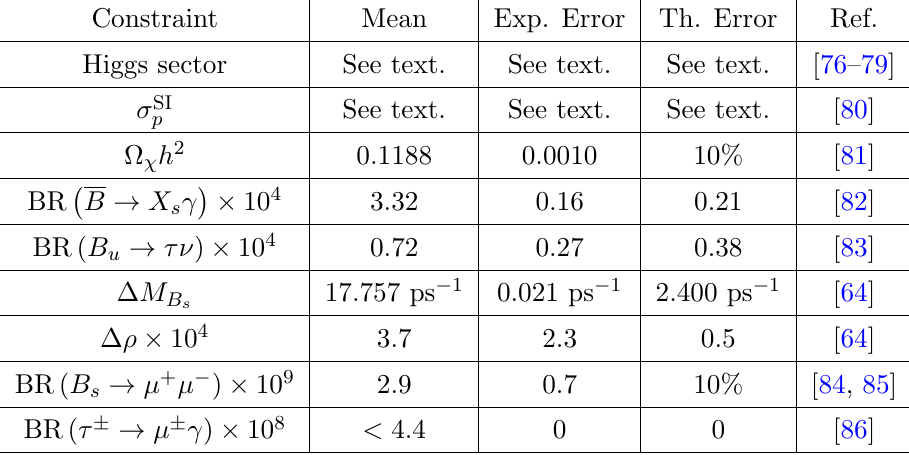
Table 1. The experimental constraints included in the likelihood